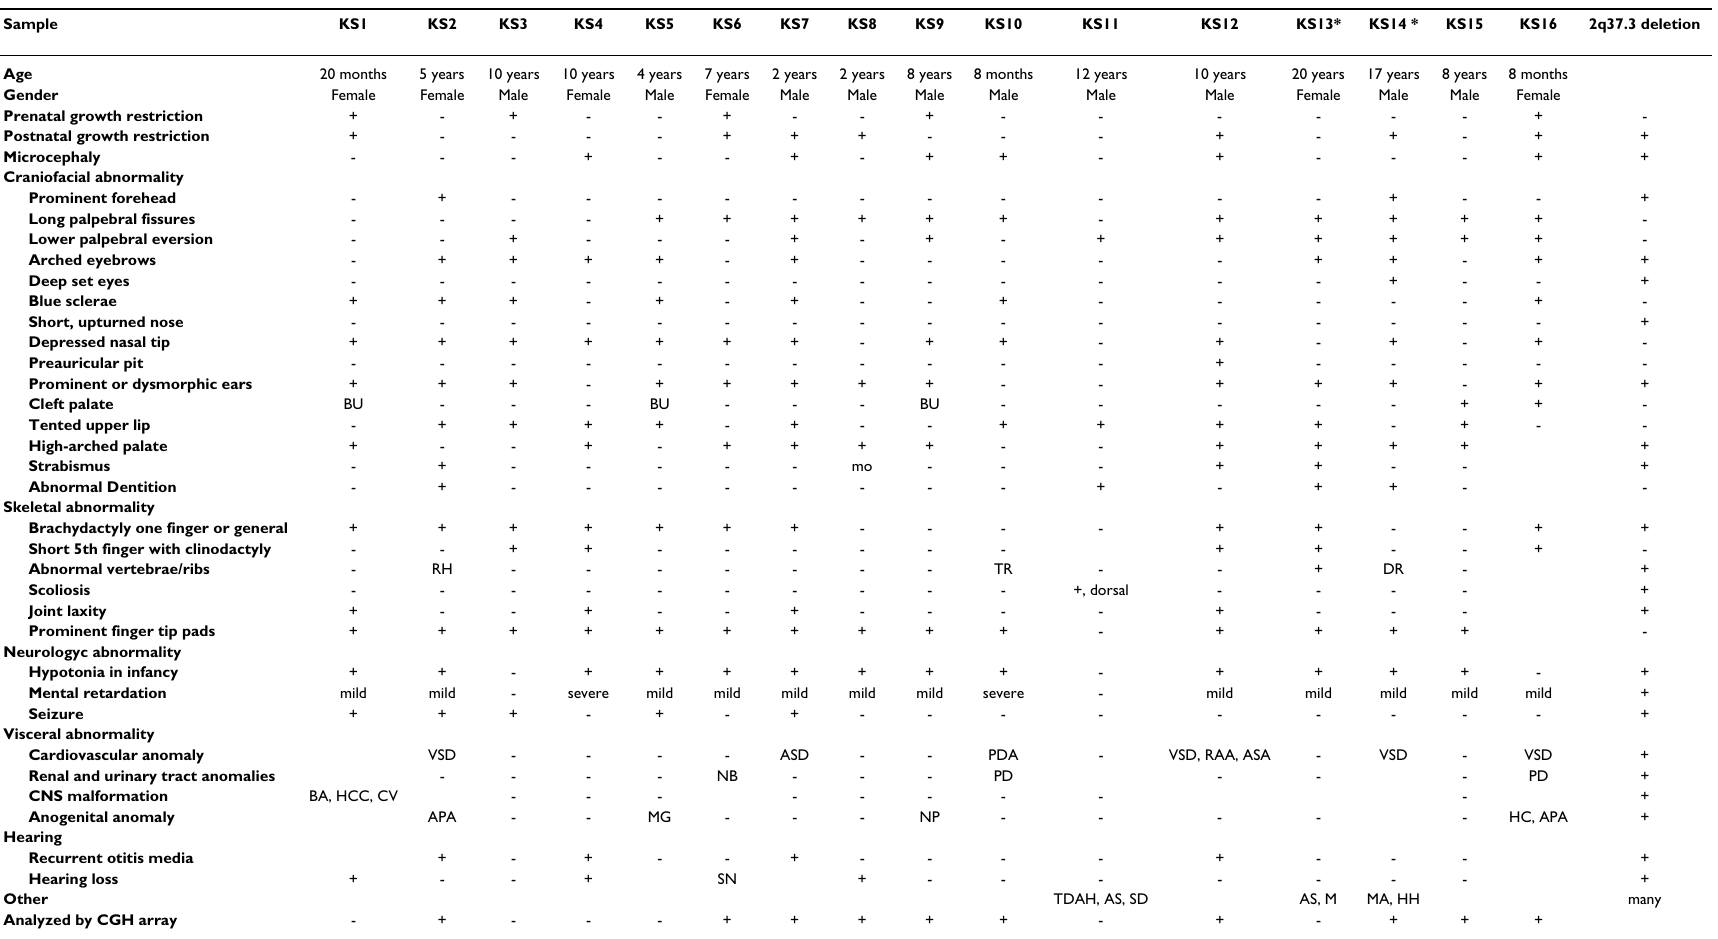
Table 1: Summary of major clinical findings in Kabuki patients. Sample